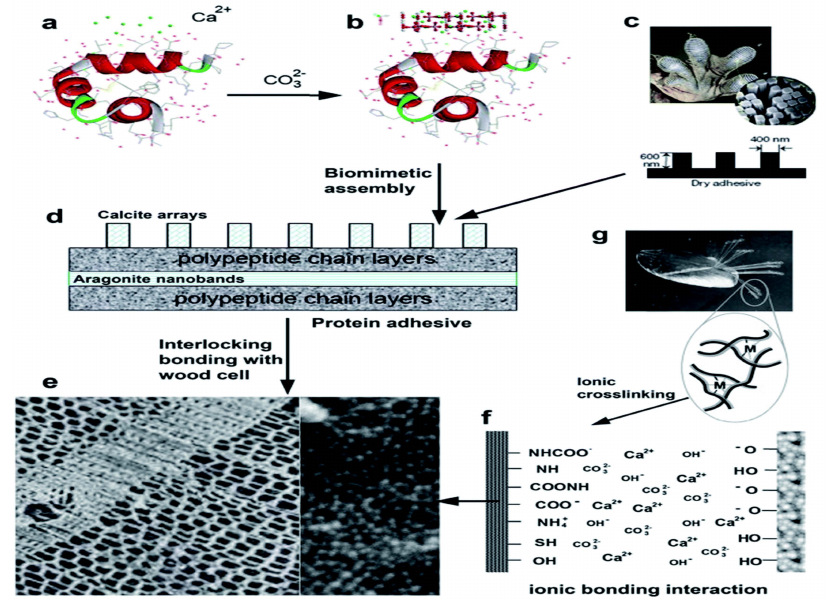
Figure 5. ( a , b , d ) Synthesis of soy protein adhesives, ( c , g ) gecko and mussel adhesive proteins, ( e , f ) mechanical and ionic crosslinking mechanisms at the surface, Reproduced from [211], Royal Society of Chemistry,